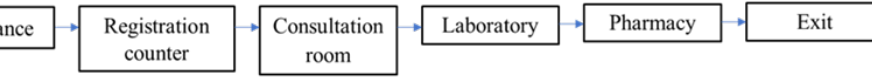
Figure 5. Exemplary wayfinding task flow within the VRE.